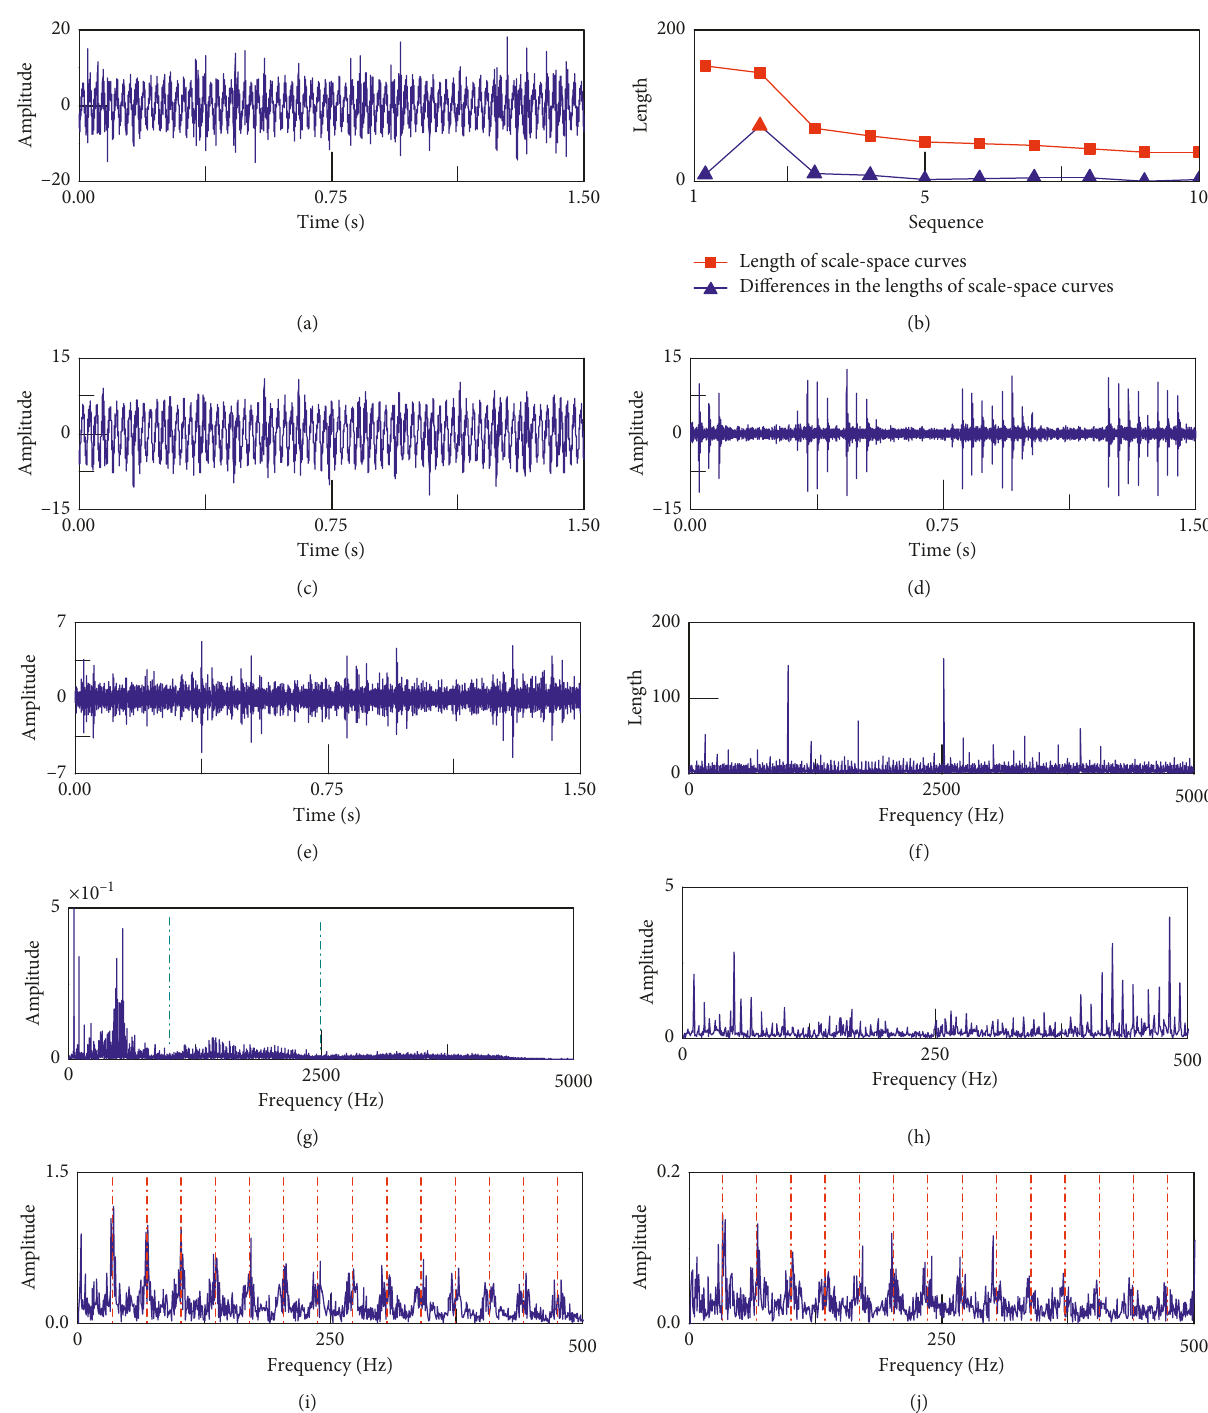
Figure 21: Results obtained by the EWTOSSR method: (a) measured signal; (b) differences in the lengths of scale-space curves; (c–e) sub- band signals; (f) OSSP, (g) detected boundaries (green dash-dotted line); (h–j) squared envelope spectra (red dash-dotted lines: f BSF and its